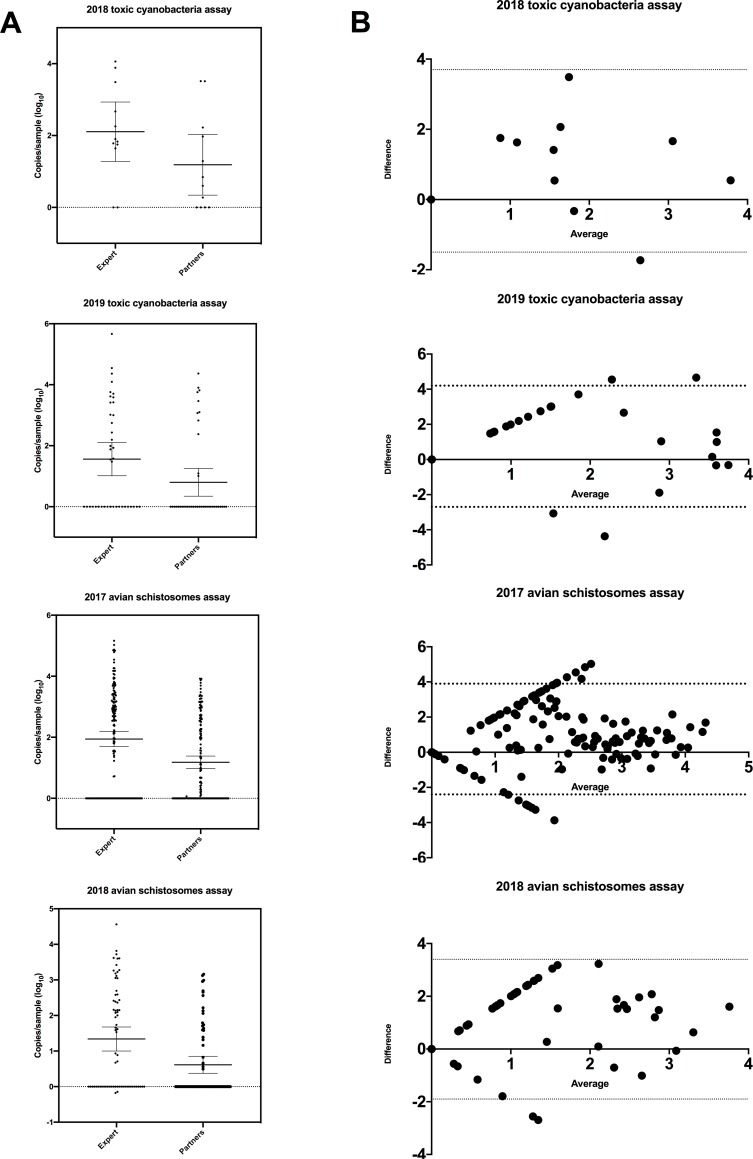
Bland-Altman graphs of the difference between the CBM partners' data and the central laboratories’ data.Limits of agreement (1.96 times the standard deviation) are bounded by the dotted lines. Top: Agreement of the 2017 Avian schistosome monitoring program. Middle: Agreement of the 2018 avian schistosomes monitoring program. Bottom: Agreement of the microcystin gene monitoring program.